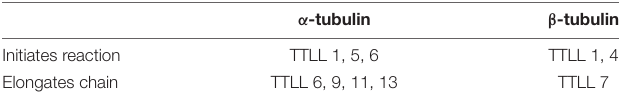
TABLE 4 | Family members of the TTLL family and their specific role in glutamylation.